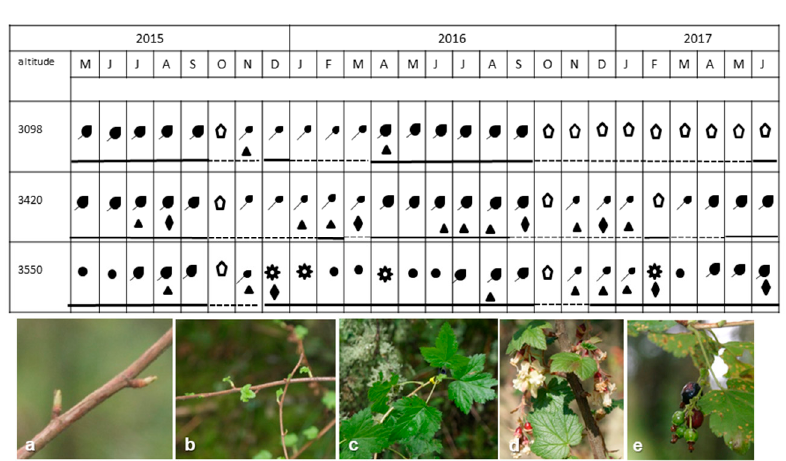
Figure 3. Phenology and cambial activity of Ribes ciliatu m over the altitudinal gradient, Sierra Ne-